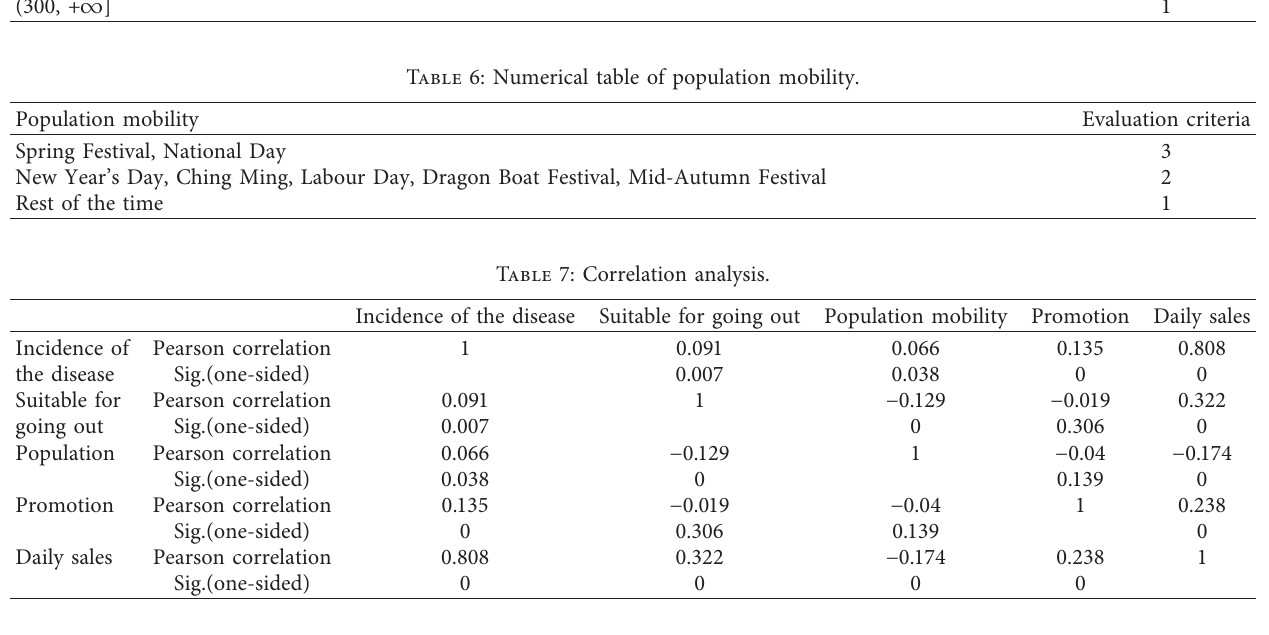
Table 8: Importance of independent variables.